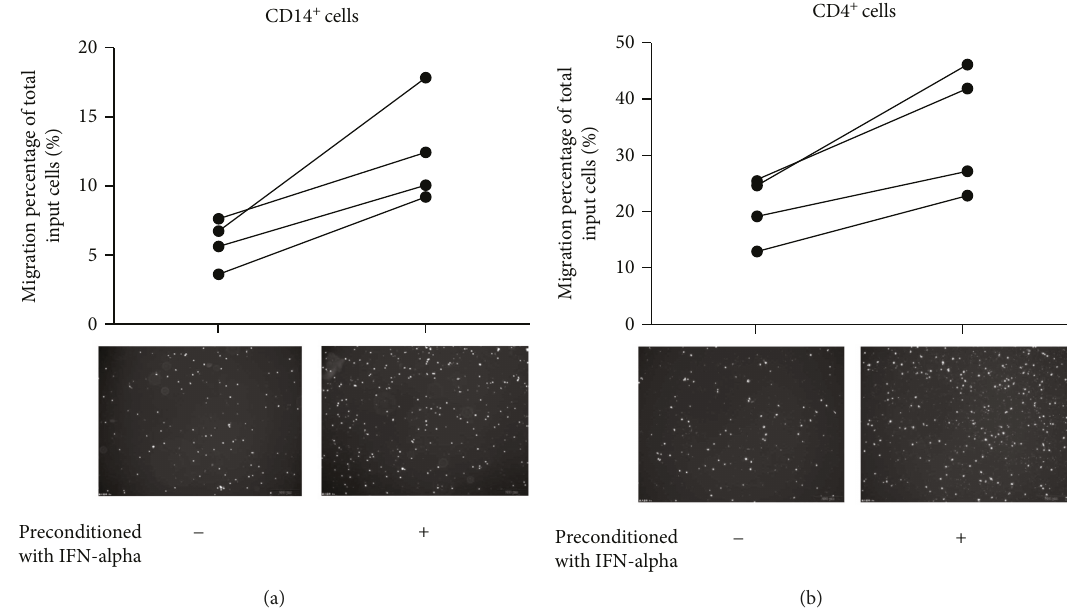
Figure 7: Transendothelial migration of CD14 + cells and CD4 + cells was promoted by IFN- α -conditioned HMC supernatant. HUVEC cells were cultured onto inserts of transwells, and the bottom champers were fi lled with culture supernatant of HMC preconditioned with recombinant IFN- α or vehicles. CD14 + cells and CD4 + cells were sorted from fresh PBMCs of donors ( n = 4 ) by fl ow cytometry and loaded on the upper wells. After migrating for 6 – 12h, migrated cells in the bottom champers were collected and counted in high power fi